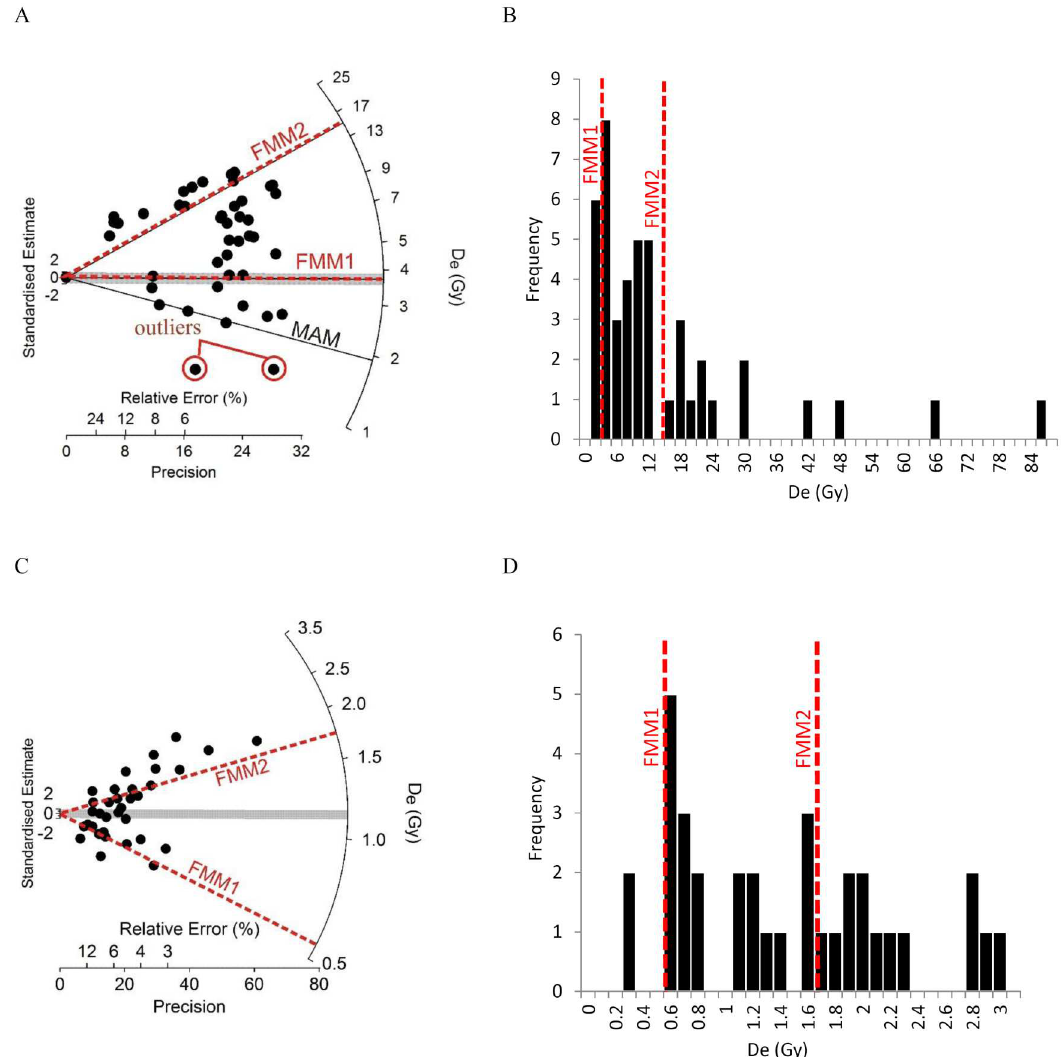
Fig 6. Multi-grain aliquot D e distribution of samples EbSh-58-1 and KB14-05-A1. These samplesare thought to containmixtures of grains from sedimentary layers of different ages. The radial plot and histogram of EbSh-58-1 are plotted in (A) and (B), respectively.The radial plot and histogramof KB14-05-A1 are plotted in (C) and (D), respectively. Finite Mixture Model components1 and 2 are shown as red dashed lines. The MinimumAge Model D e value of sample EbSh-58-1 is shown as a solid black line, and was calculatedafter excludingtwo anomalously low D e values